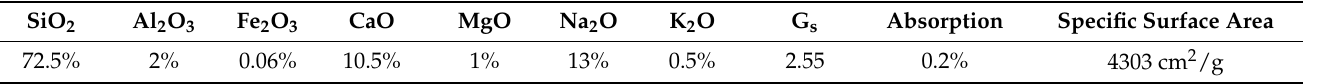
Table 1. Physical and chemical properties of the glass powder produced from waste glass in this study. SiO 2 Al 2 O 3 Fe 2 O 3 CaO MgO Absorption 72.5%